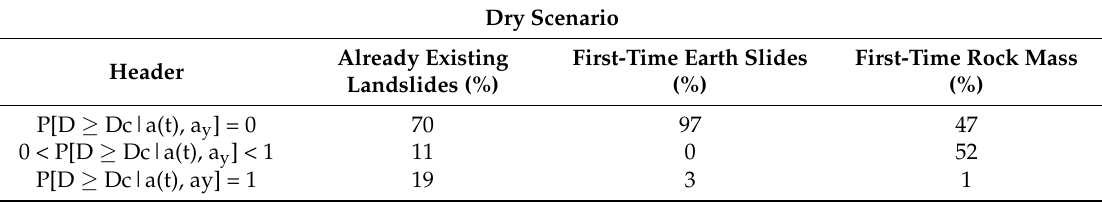
Table 2. Results obtained in terms of exceedance probability for the dry scenario (RT = 475 years).